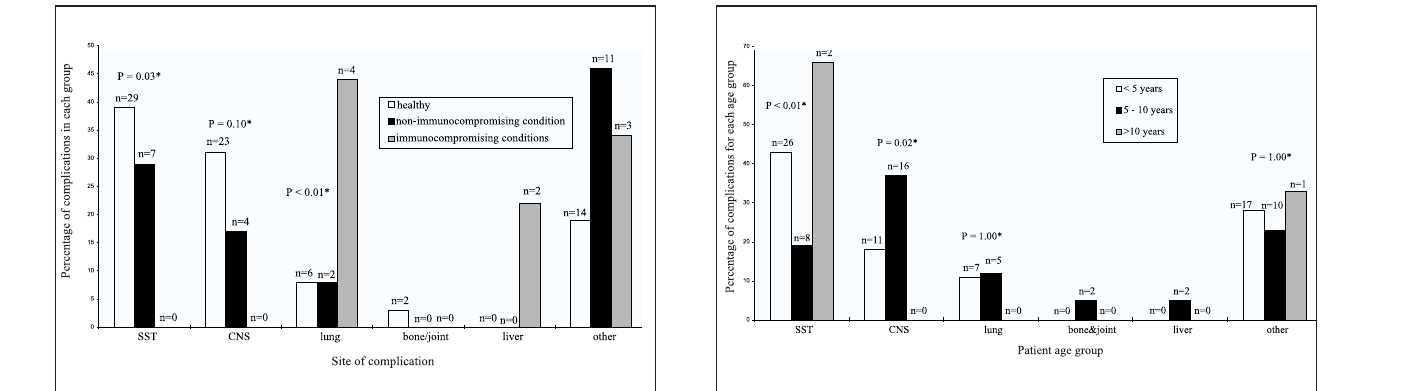
Figure 2) Sites of varicella zoster virus complications leading to ad- mission, by patient health status group. *Comparisons made between immunocompetent (healthy and nonimmunocompromising condi- tions) and immunocompromised patients. CNS Neurological complica- tions; SST Skin and soft tissue infection